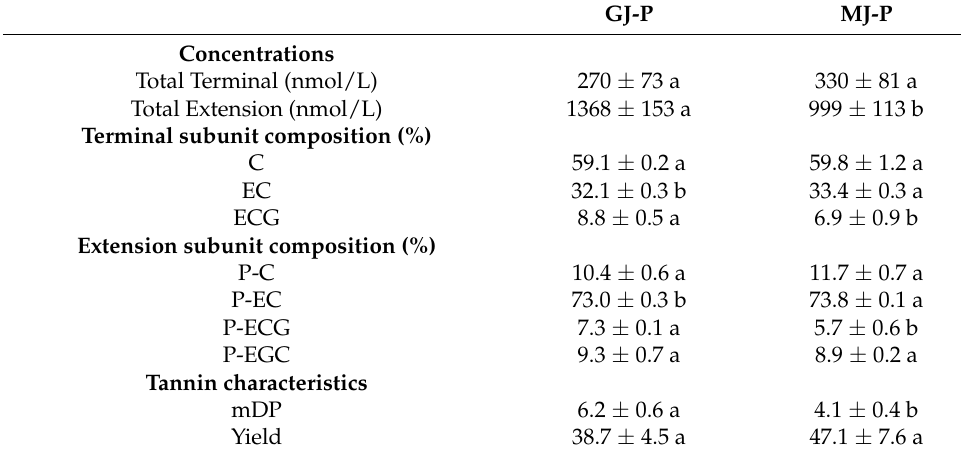
Table 3. Tannin mean degree of polymerisation (mDP) and composition in wines. GJ-P MJ-P Concentrations Total Terminal (nmol/L) 270 ± 73